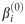
Bézier curve formation following de Casteljau’s algorithm.Shown are the (top-level) control points βi(0) and the recursive control points βi(1), βi(2), and βi(3). Number of sampling points is set at τ = 3. For clarity, intervals t=03 and t=33 are not shown, except for β(3) in panel d. The four figure panels show the sequential application of the algorithm: top-left (a): β(0)=〈β0(0),β1(0),β2(0),β3(0)〉; top-right (b): βn(1)=(1-t)βn(0)+tβn+1(0); bottom-left (c): βn(2)=(1-t)βn(1)+tβn+1(1)=(1-t)2βn(0)+2(1-t)tβn+1(0)+t2βn+2(0); and bottom-right (d): βn(3)=(1-t)βn(2)+tβn+1(2)=(1-t)3βn(0)+3(1-t)2tβn+1(0)+3(1-t)t2βn+2(0)+t3βn+3(0).